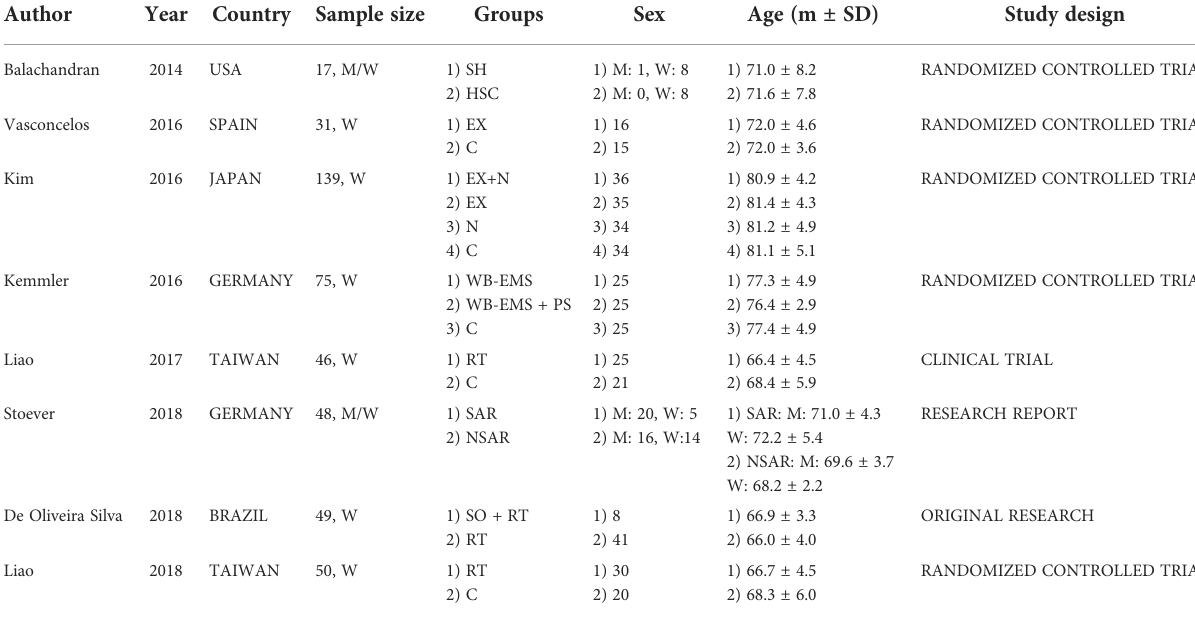
TABLE 1 General characteristics of the